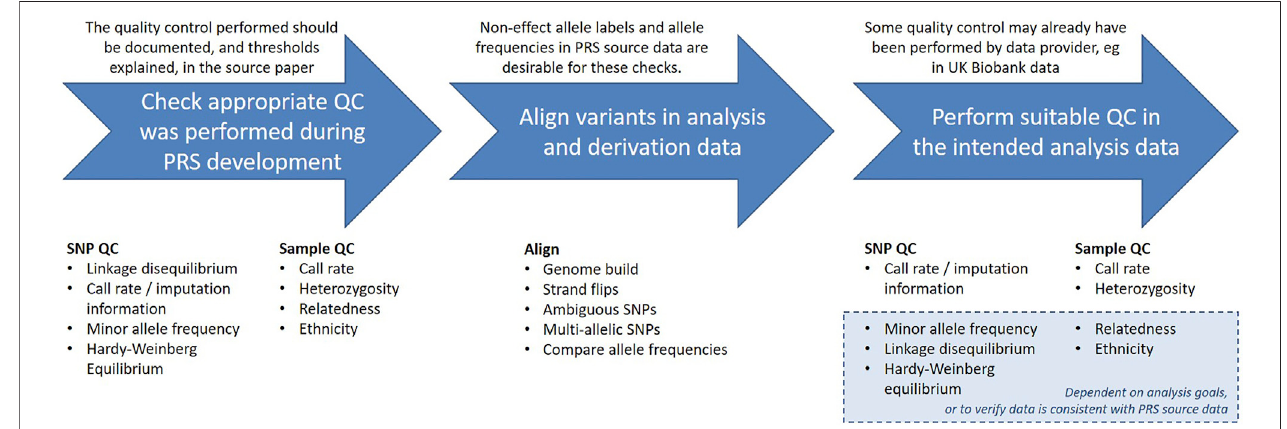
FIGURE 2 | Summary of quality control and alignment